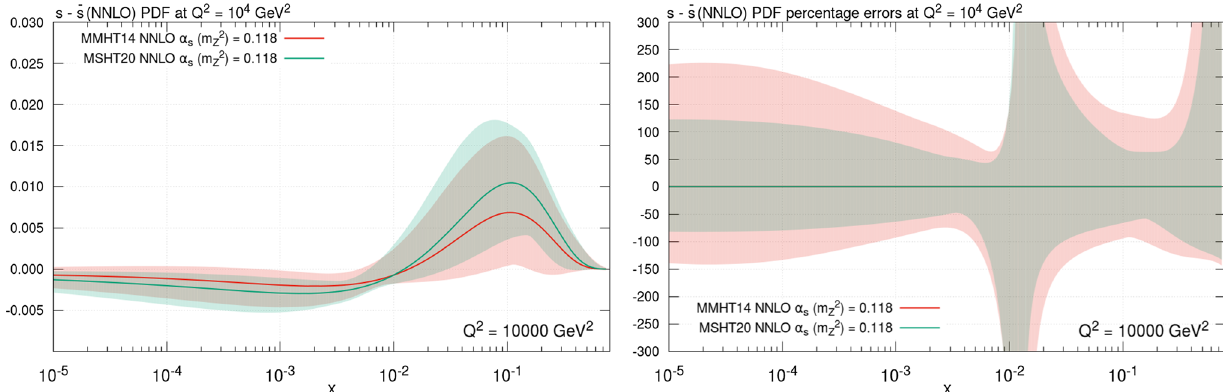
Fig. 28 s − ¯ s PDFs, for MSHT20 and MMHT14 at NNLO and Q 2 = 10 4 GeV 2 . In the (left) plot the absolute values of the PDFs are shown rather than the ratio as it passes through zero. In the (right)